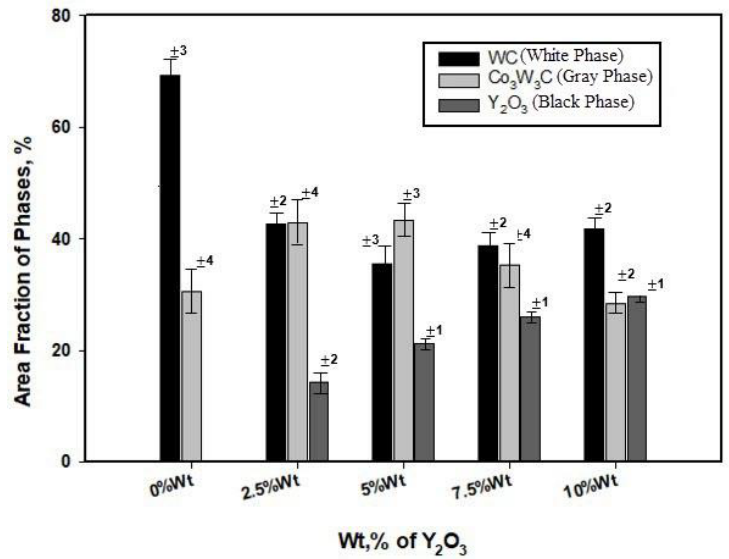
Figure 12. Bar chart for the area fraction of the three phases: WC (white phase), Co 3 W 3 C (gray phase), and Y 2 O 3 (black phase), calculated using image analysis of the SEM micrographs shown in Figure 11.